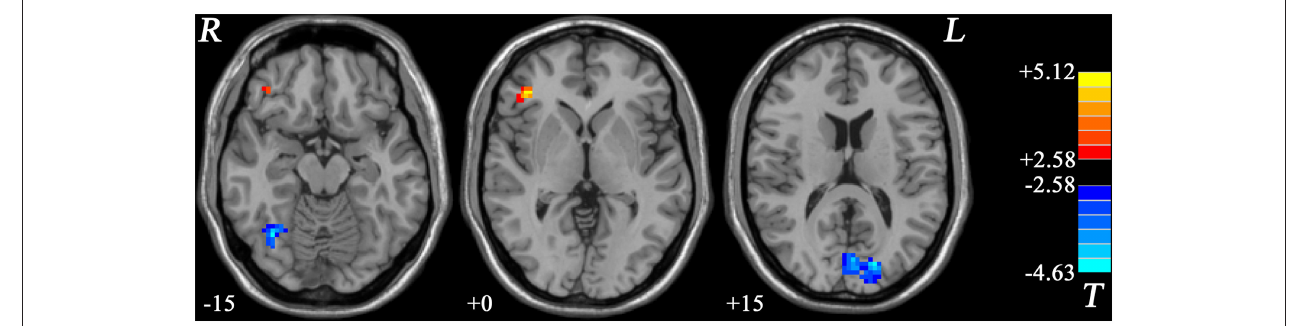
FIGURE 3 | Statistical maps showing the fALFF differences between GI-MDD patients and HCs. The color bar indicates t values from post-hoc t -tests. Red and blue colors denote increased and decreased fALFF, respectively. fALFF , fractional amplitude of low-frequency fluctuation; GI-MDD , major depressive disorder with gastrointestinal symptoms; HCs , healthy controls.